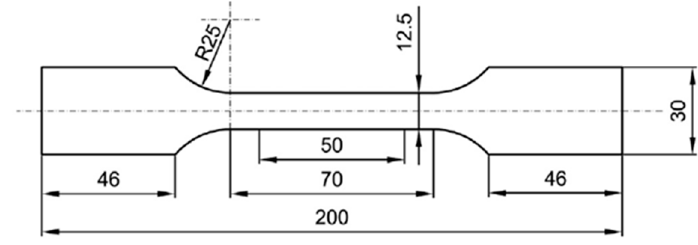
Figure 1. Sample geometry for tensile testing (unit: mm).